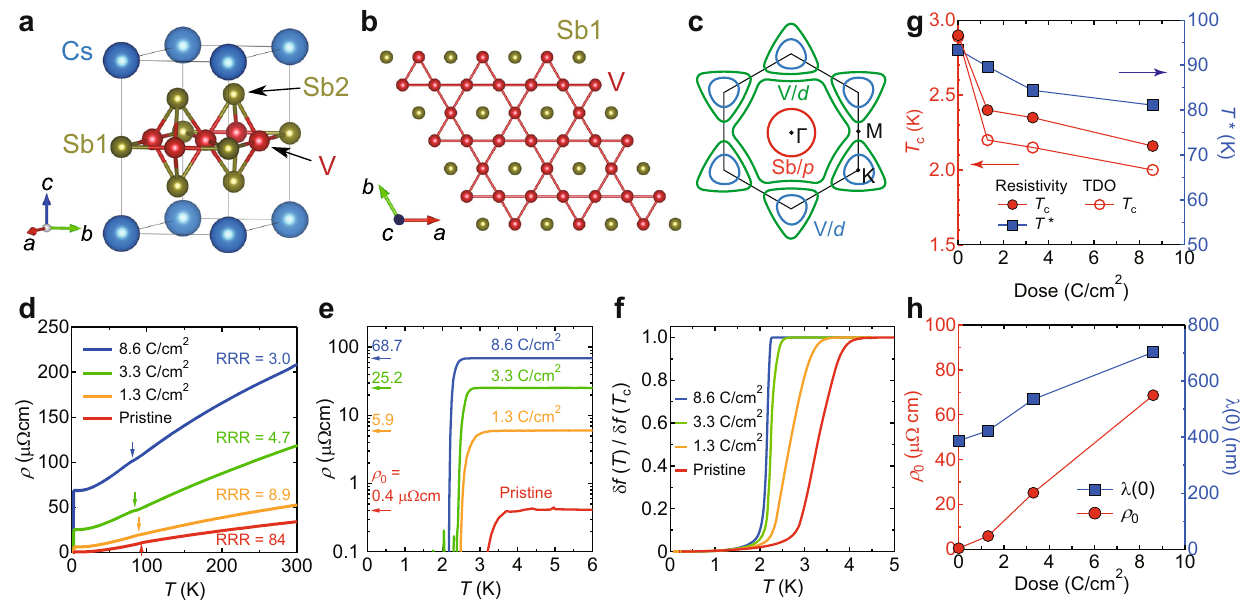
Fig. 1 | Crystal structure, Fermi surface, and electronirradiation effects on the charge-density-wave and superconducting transition temperatures in CsV 3 Sb 5 . a Crystal structure of CsV 3 Sb 5 . b V-Sb1 plane viewed from the c -axis direction. Whereas the V atoms form a two-dimensional kagome network, the Sb1 atoms arelocated atthe hexagonalcenters. c Schematicof the 2DFermisurface of CsV 3 Sb 5 . The circular (red) and hexagonal (green) Fermi surfaces around the Γ pointarecomposedoftheSb p -orbitalsandV d -orbitals,respectively,whilethetwo triangular Fermi surfaces (blue and green) around the K point are formed by the V d -orbitals. d Temperature dependence of resistivity ρ ( T ) in CsV 3 Sb 5 single crystals with irradiated doses of 0 (pristine, red), 1.3 (orange), 3.3 (green), and 8.6 (blue) C/cm 2 . The RRR values for each sample are listed. Arrows indicate the CDW transition temperatures determined from the temperature derivative of ρ ( T ) (see Fig. 4b, f, j). Note that the ρ ( T ) curves for the irradiated samples do not shift